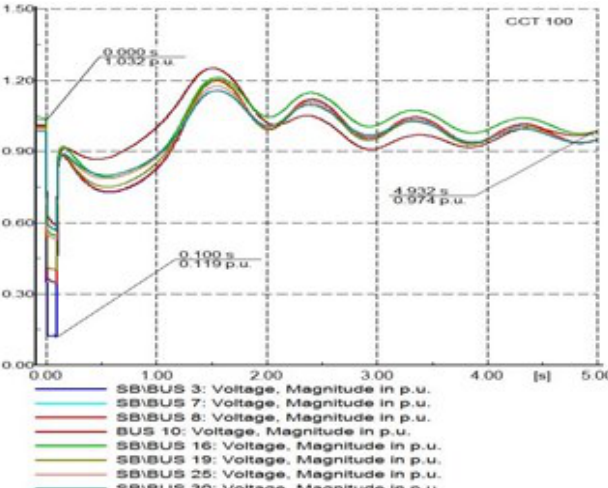
Fig. 11. Generator excitation current (Without HVDC line).